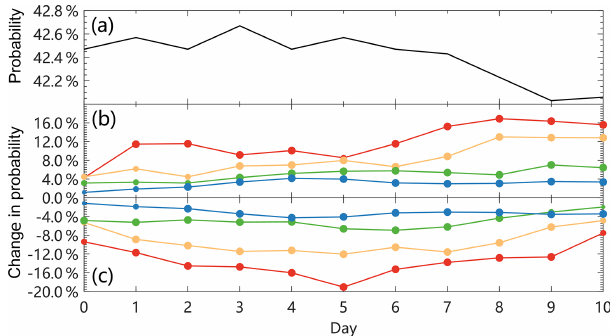
Figure 7. The percentage of persistent haze days in haze days at Day i ( i = 0...10) on the condition that (a) the state of the WNAO is unknown, (b) the 5d moving average WNAO index is above the 95th (red), 90th (yellow), 75th (green) and 50th (blue) percentiles of the moving average series, and (c) when the 5d moving average WNAO index is below the 50th (blue), 25th (green), 10th (yellow) and 5th (red) percentiles of the moving average